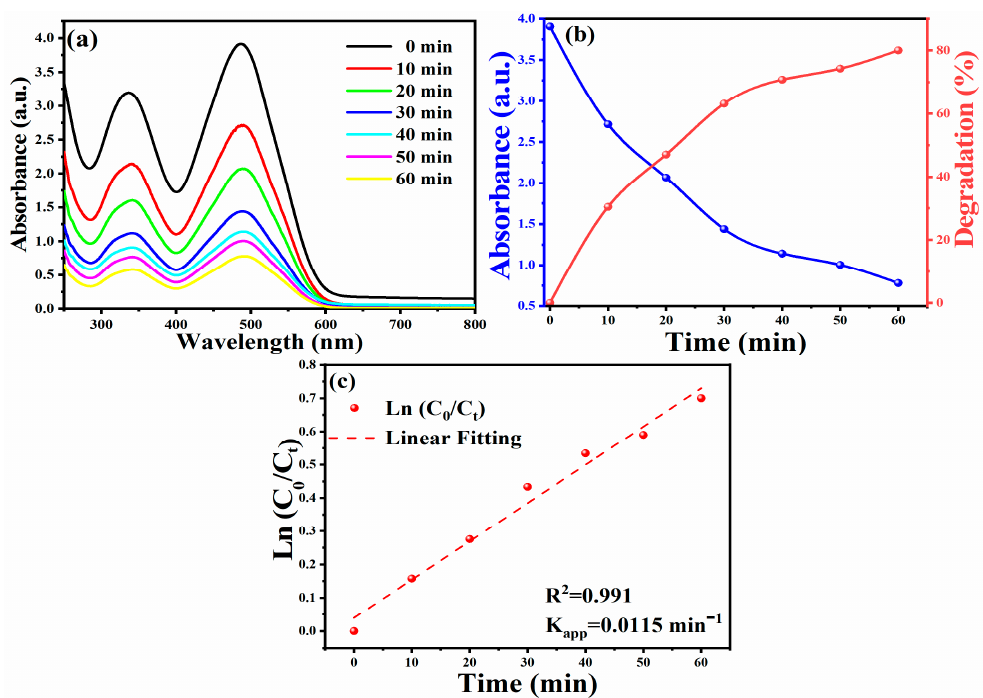
Figure 4. UV–vis spectra versus under optimal reaction conditions ( a ); absorbance and degradation versus time ( b ); plot of ln ( C 0 / C t ) versus time ( c ) for the Ag/Ag 2 O NPs catalyzed degradation of CR